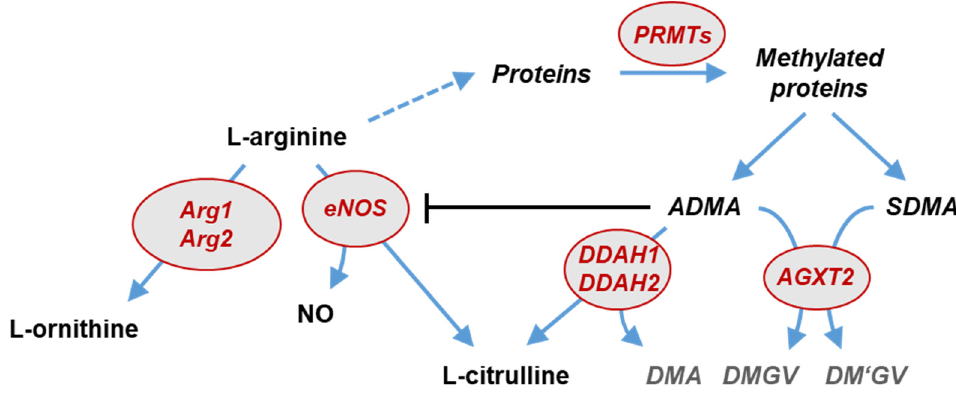
Figure 1. Schematic representation of the L-arginine—dimethylarginine—nitric oxide pathway. L-arginine is the substrate for endothelial NO synthase and arginases, resulting in the formation of NO and L-citrulline or L-ornithine, respectively. L-arginine residues within specific proteins are subject to methylation by protein arginine N-methyltransferases (PRMTs). After protein hydrolysis, asymmetric (ADMA) and symmetric dimethylarginine (SDMA) are released. ADMA is a competitive inhibitor of nitric oxide synthases (NOS). ADMA, but not SDMA, is degraded by dimethylarginine dimethylaminohydrolases (DDAH1 and DDAH2) into L-citrulline and dimethylamine (DMA). Both dimethylarginines may be cleaved by an alternative pathway through alanine glyoxylate aminotransferase 2 (AGXT2), resulting in the formation of symmetric or asymmetric dimethylguanidinovaleric acid (DMGV and DM’GV). Genes in which single nucleotide polymorphisms were studied in the present study are highlighted in red.